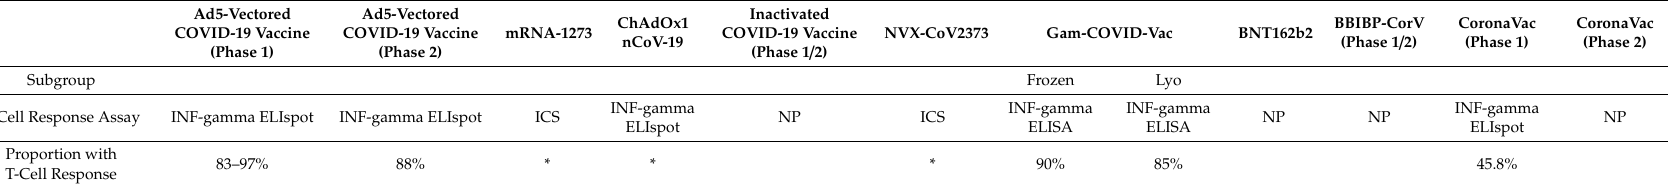
Table 5. Immunogenicity of vaccines as measured by T-cell